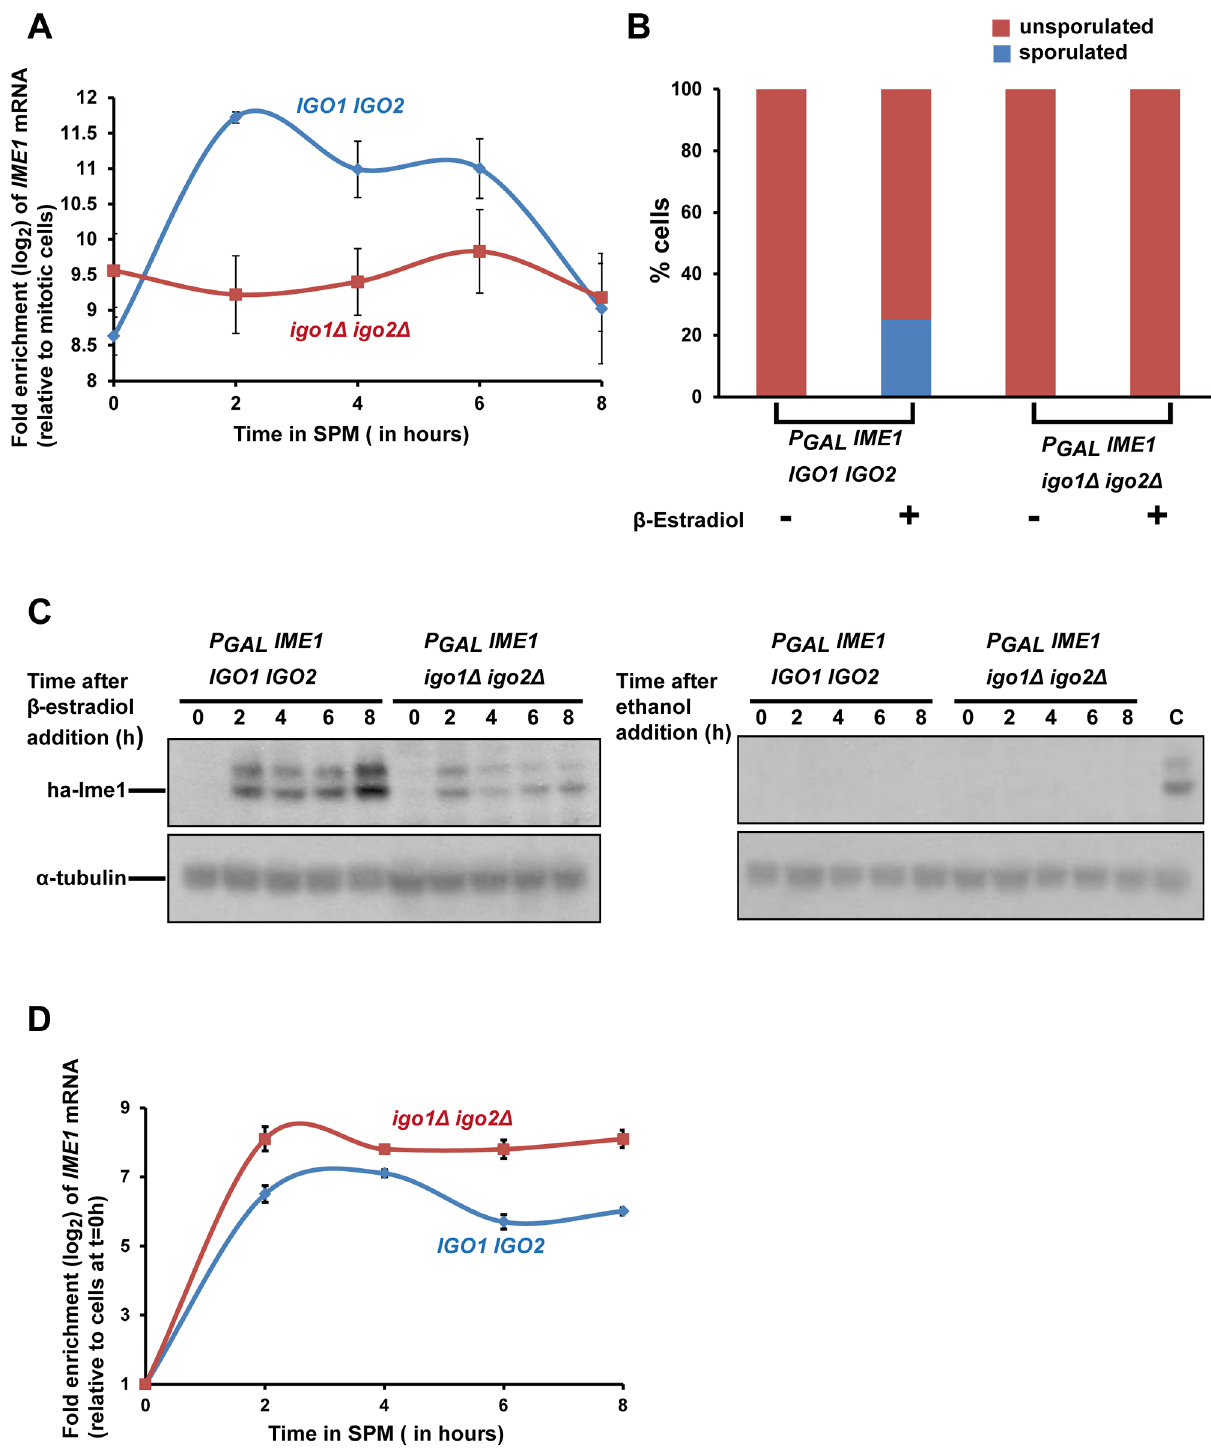
Figure 6. Endosulfines are required for transcriptional induction of IME1 caused by transfer of cells to sporulation medium. A) Wild- type and igo1 D igo2 D cells were induced to enter meiosis by transferring them to sporulation medium (SPM). Total RNA was prepared from cells after 0, 2, 4, 6 and 8 hours following transfer to SPM and IME1 transcript levels were assayed by quantitative RT-PCR. The IME1 transcript levels were normalized with respect to ACT1 mRNA and expressed relative to normalized IME1 transcript levels in mitotically grown cells. B) Wild-type and igo1 D igo2 D cells containing P GAL - ha 3- IME1 GAL4-ER were induced to sporulate. Either b -estradiol or ethanol was added to the cultures at t=0 h. After 24 hours, sporulation efficiency was measured (n=200). C) Aliquots of cells in B were collected after 0, 2, 4, 6 and 8 hours following addition of b - estradiol/ethanol and total cell extracts were prepared. Immunoblotting was performed using an anti-HA antibody and anti-tubulin antibody. The lane labelled C on the western image on the right contained extracts from b -estradiol treated wild type cells (t=4 hours) and served as a positive control. D) Aliquots of cells in B were collected after 0, 2, 4, 6 and 8 hours following addition of b -estradiol and total RNA from the cells was prepared.